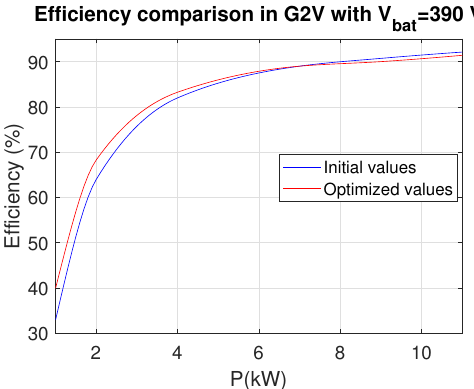
Figure 19. Efficiency comparison in G2V mode with V bat = 390 V.